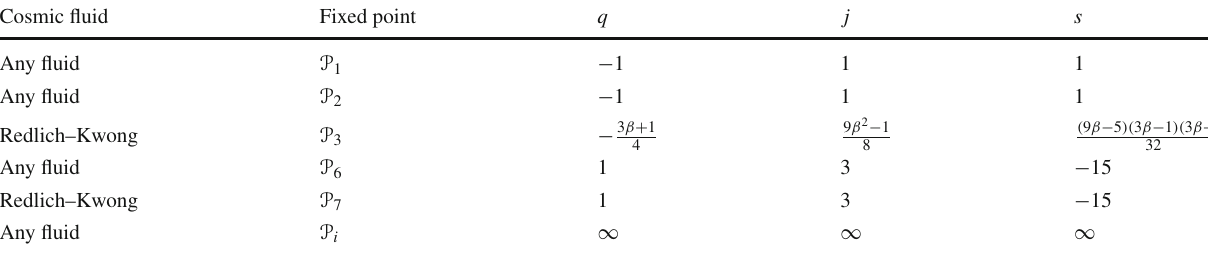
for a correct interpretation of these results it is necessary to take into account the appropriate range of validity for the parameter β for each equilibrium point separately, as summarized in Table